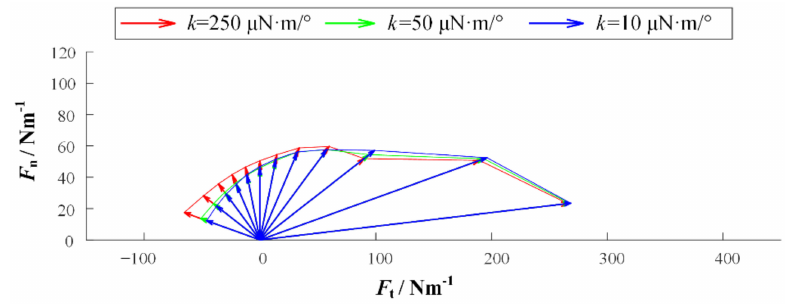
Figure 6. Distribution of desorption forces on flexible surfaces.